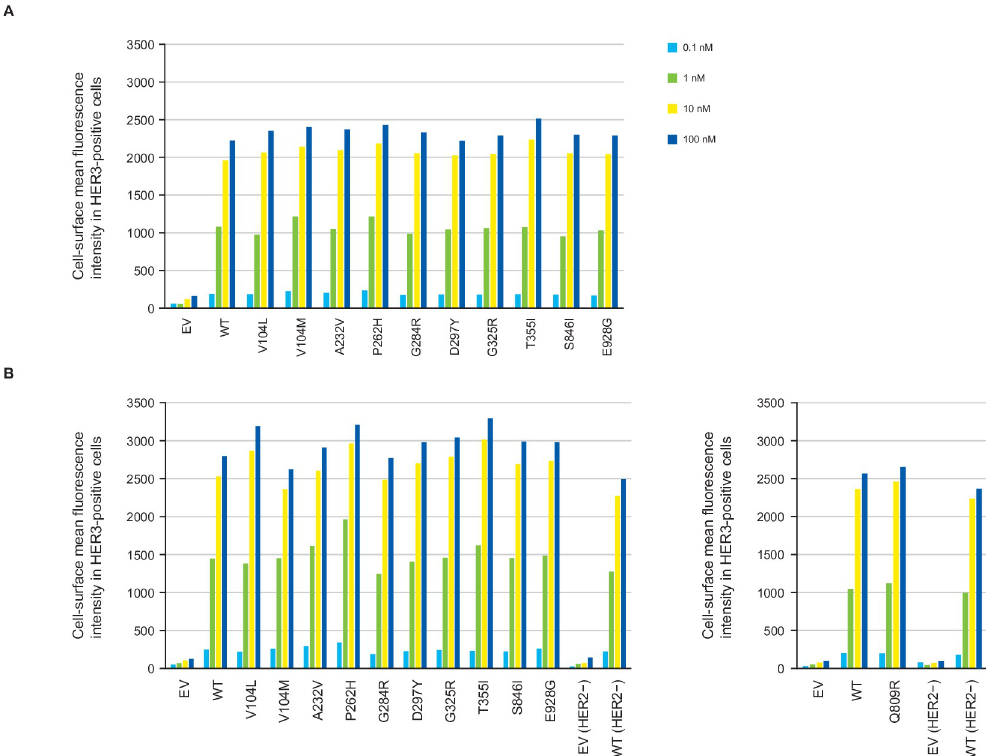
Fig 1. Cell-surface binding of HER3-DXd in MDA-MB-231 cells transduced with HER3 WT , HER3 mutations, or HER3 EV in the absence (A) or presence (B) of HER2 overexpression. Cells were incubated with 0.1, 1, 10, and 100 nM HER3-DXd, followed by secondary antibody (10 mg/mL Alexa Fluor 647 goat antihuman IgG). The cell-surface binding of HER3-DXd was assessed by flow cytometry and expressed as the mean fluorescence intensity of the cells that were stained positive for HER3-DXd. Abbreviations: EV = empty vector, HER = human epidermal growth factor receptor, WT = wild type.